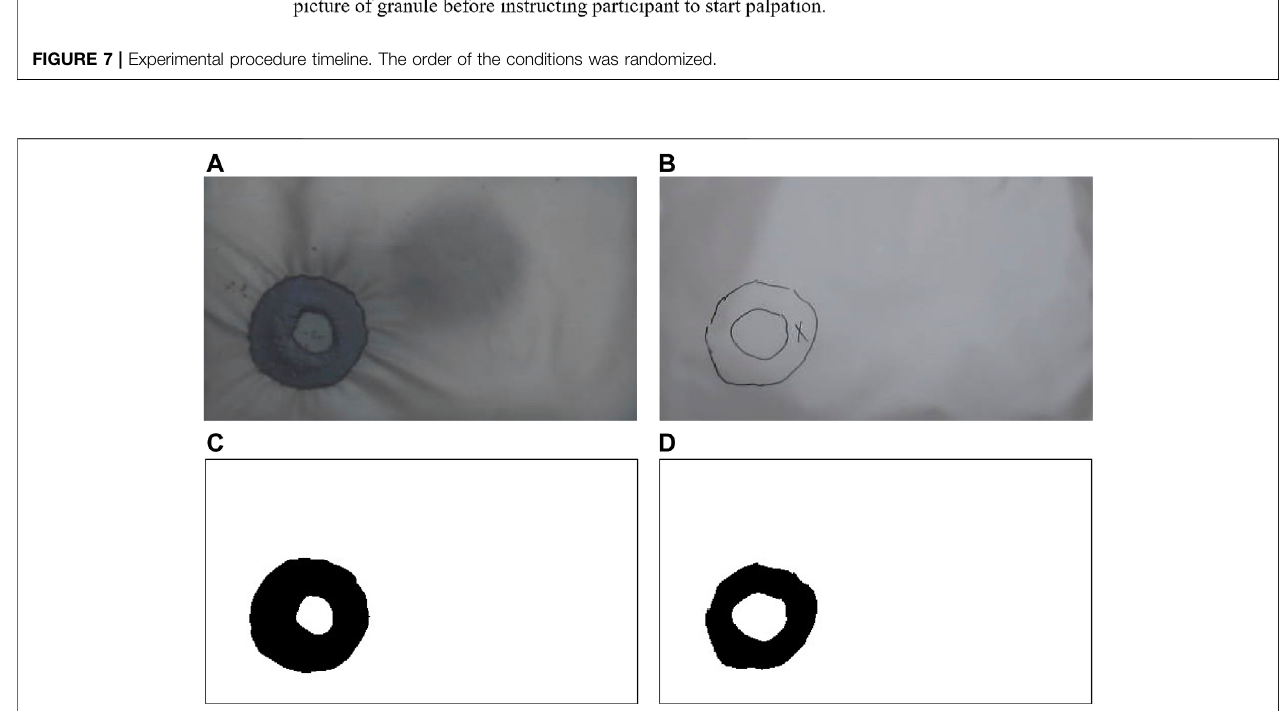
FIGURE 8 | Unprocessed images of (A) Granulate and (B) Drawing. Binarized pictures of (C) Granulate and (D) Drawing.